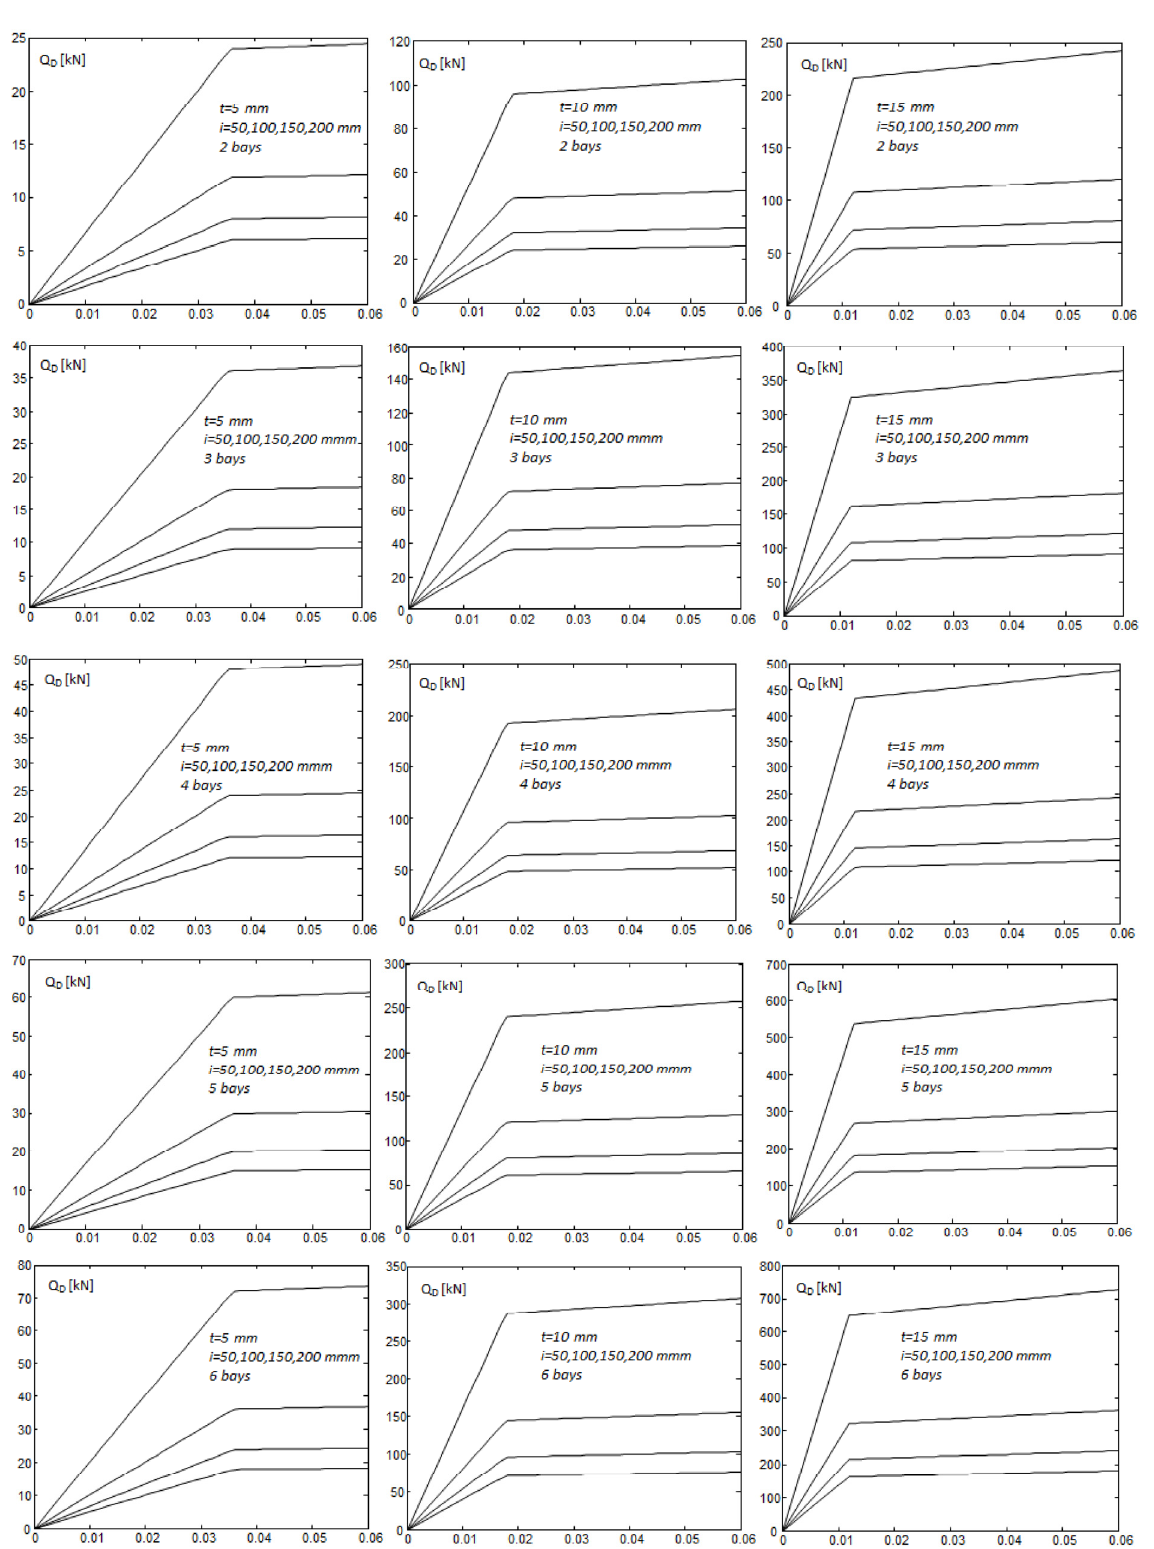
Figure 15. Parametric analysis of the force-displacement relationships of the model for different values of the thickness t , number of bays and plates distance i